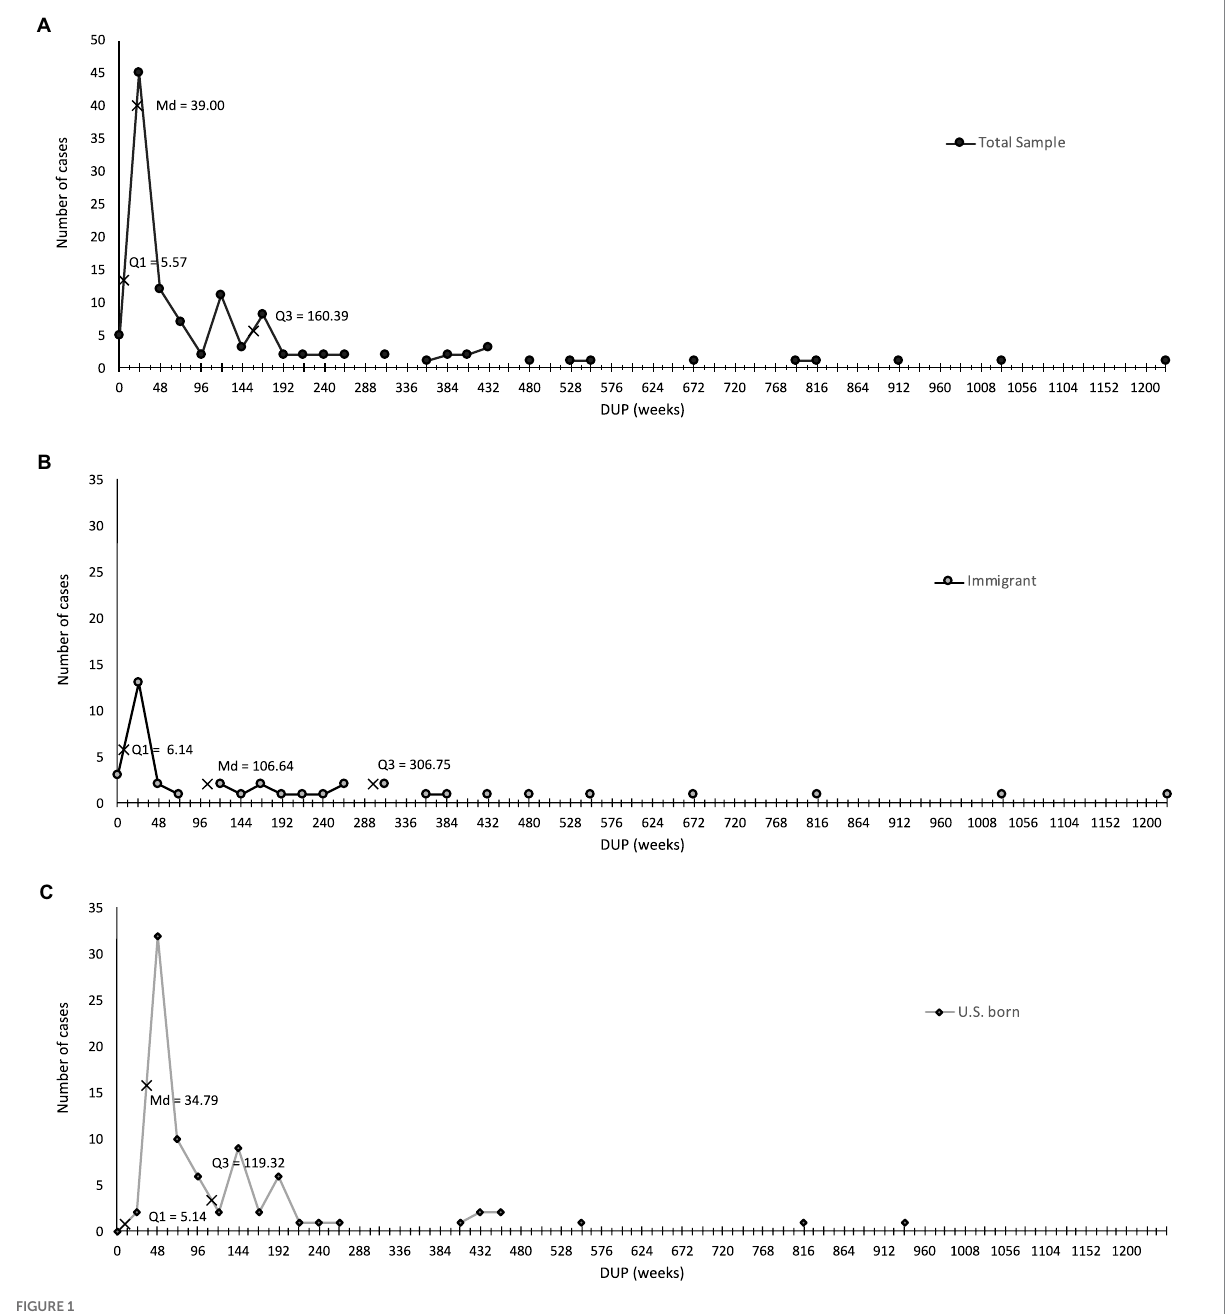
FIGURE 1 The delay to first prescribed antipsychotic medication after the onset of psychosis in a sample of U.S. Latinxs. (A) Distribution of DUP for full Latinx sample. (B) Distribution of DUP for immigrant Latinx sample. (C) Distribution of DUP for U.S-born Latinx